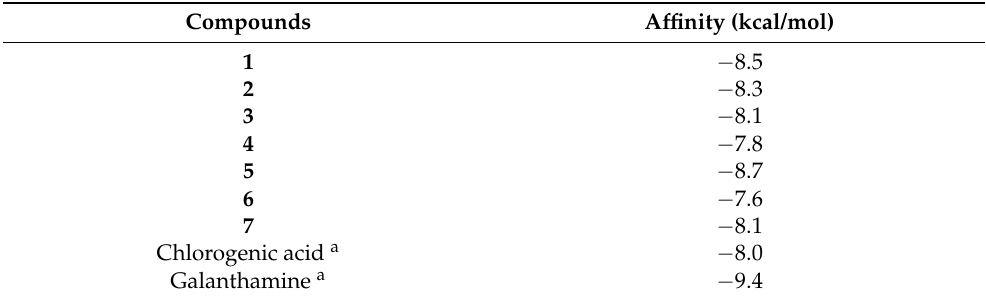
Figure 5. Interactions of euscaphic acid ( 5 ) with active sites of acetylcholinesterase from Electrophorus electricus . Table 7. Binding energies of active components with acetylcholinesterase from Electrophorus electricus calculated in